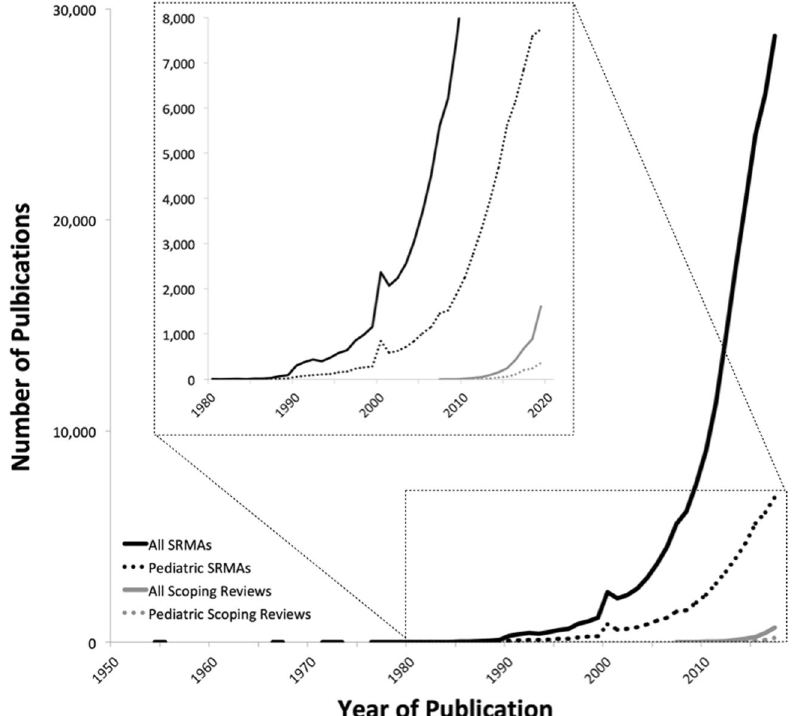
Fig. 1 Rate of publication of reviews over time. Graphical representation of the rapid increase in scoping reviews publication. SRMA systematic reviews and